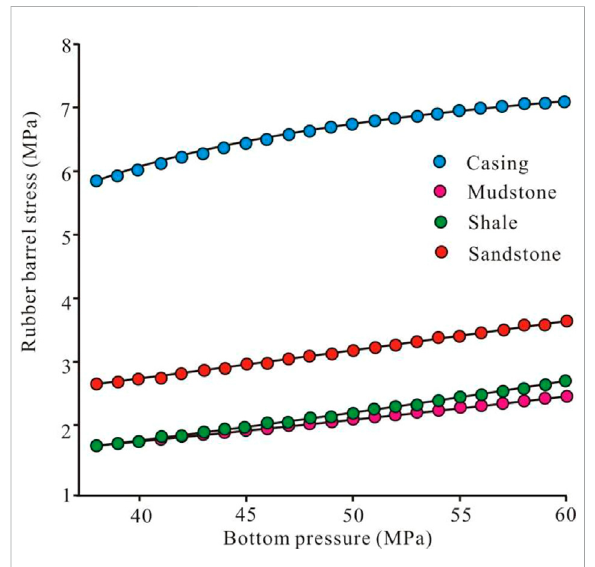
FIGURE 5 Variation of maximum formation shear stress under different contact